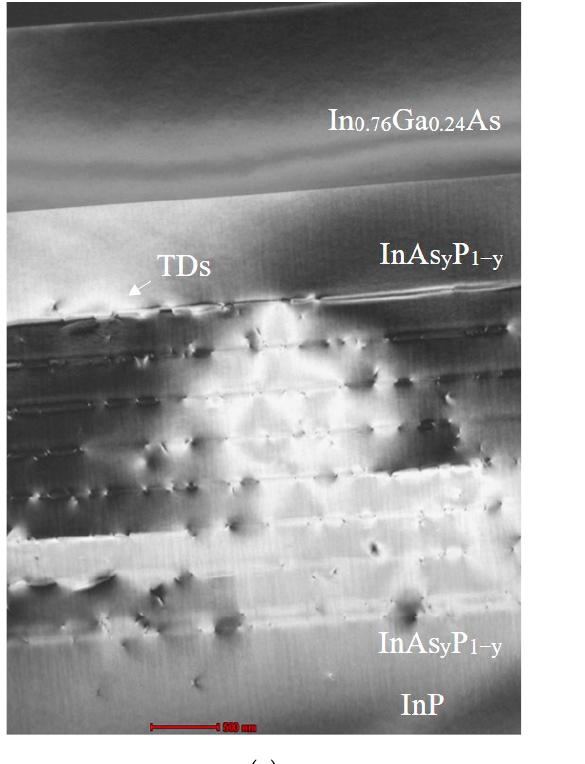
( b ) Figure 6. ( a ) PL spectra of extended wavelength InGaAs sample at room temperature. ( b ) PL spectra of extended wave- length InGaAs sample A at different temperatures from 10 K to 300 K (Intensity is plotted in logarithm scale).